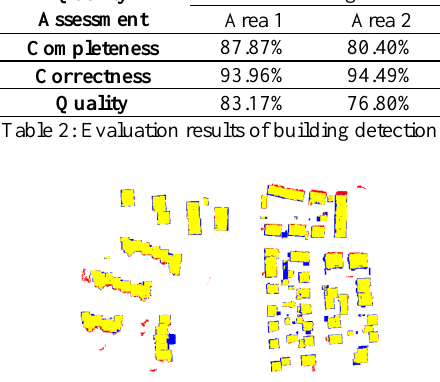
Figure 8: Evaluation results schematically (yellow: TP , red: FP , blue: FN ) Figure 11: The reconstructed building, (a) detected parcel, (b) ridge line with boundary, (c) separated planes of roof, (d) the roof corners, (e) 3D model, (f) Reconstructed 3D model on range image of